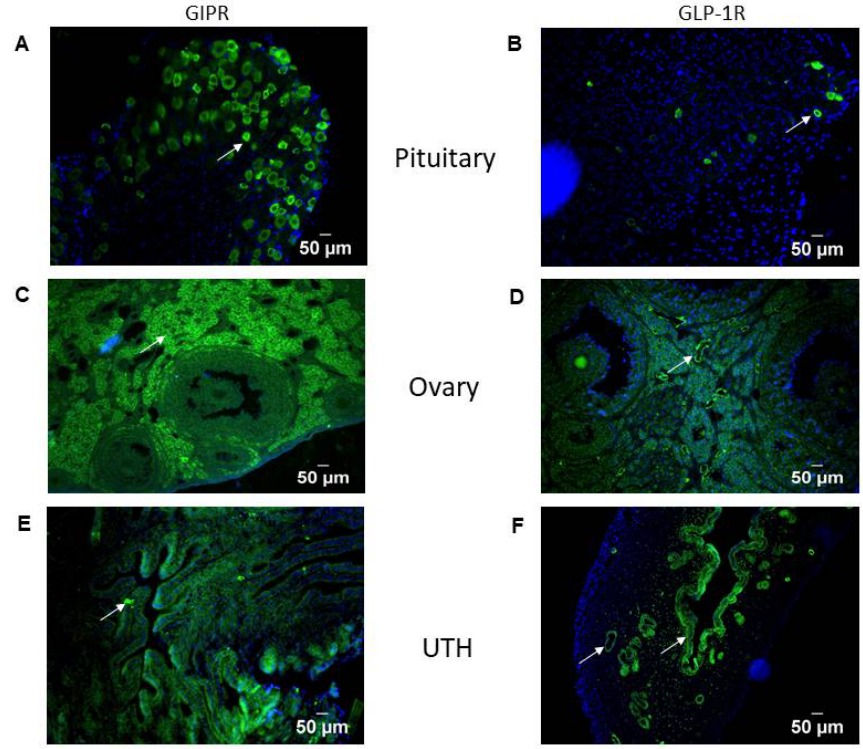
Figure 2. GLP-1 and GIP receptor protein expression in pituitary, ovary and uterine horn of female GIPR-Cre and GLP1R-Cre mice. ( A – F ) Representative histological images of pituitary, ovary and uterine horn (UTH) showing GIPR/GLP-1R (green, indicated by arrows) staining with DAPI (blue) demonstrating nuclei. Representative images shown with scale bars.